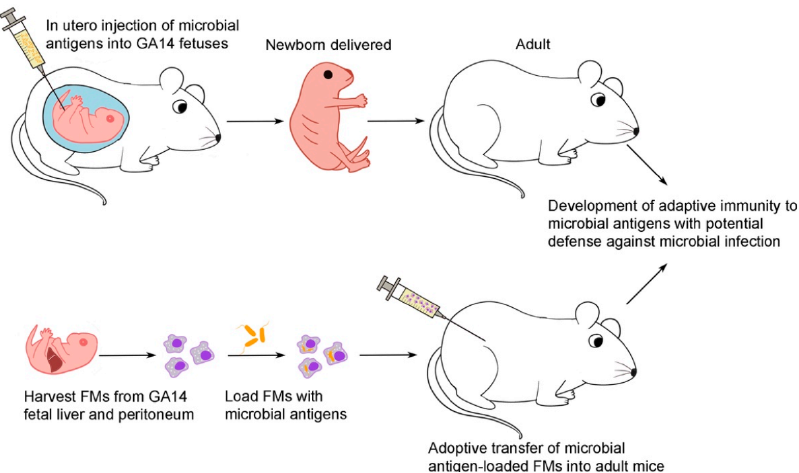
Figure 8. Scheme of experimental design and results. This graph summarizes the experiments and the main results to facilitate the understanding of this work. GA14, gestational day 14; FM, fetal